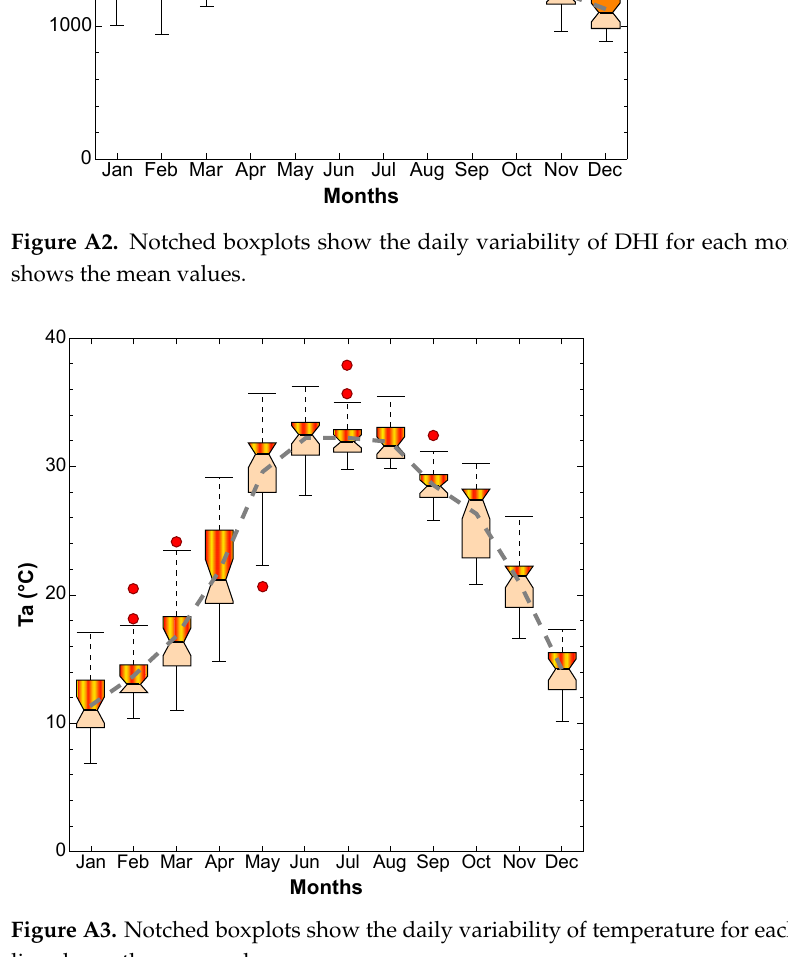
Figure A3. Notched boxplots show the daily variability of temperature for each month; the dashed line shows the mean values.